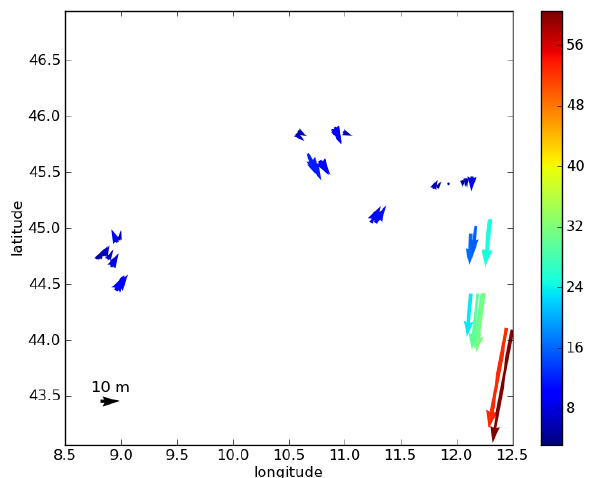
Figure 7: TODO: create nicer figure. Evaluation of the bun- dle block adjustment against checkpoints extracted from the Re- alVista aerial images. Each arrow represents the mean X and Y error of a stereo pair.